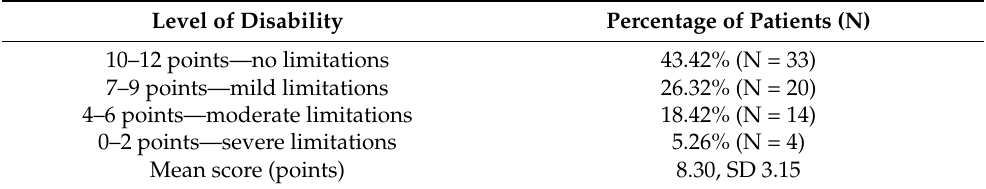
Table 4. Short Physical Performance Battery